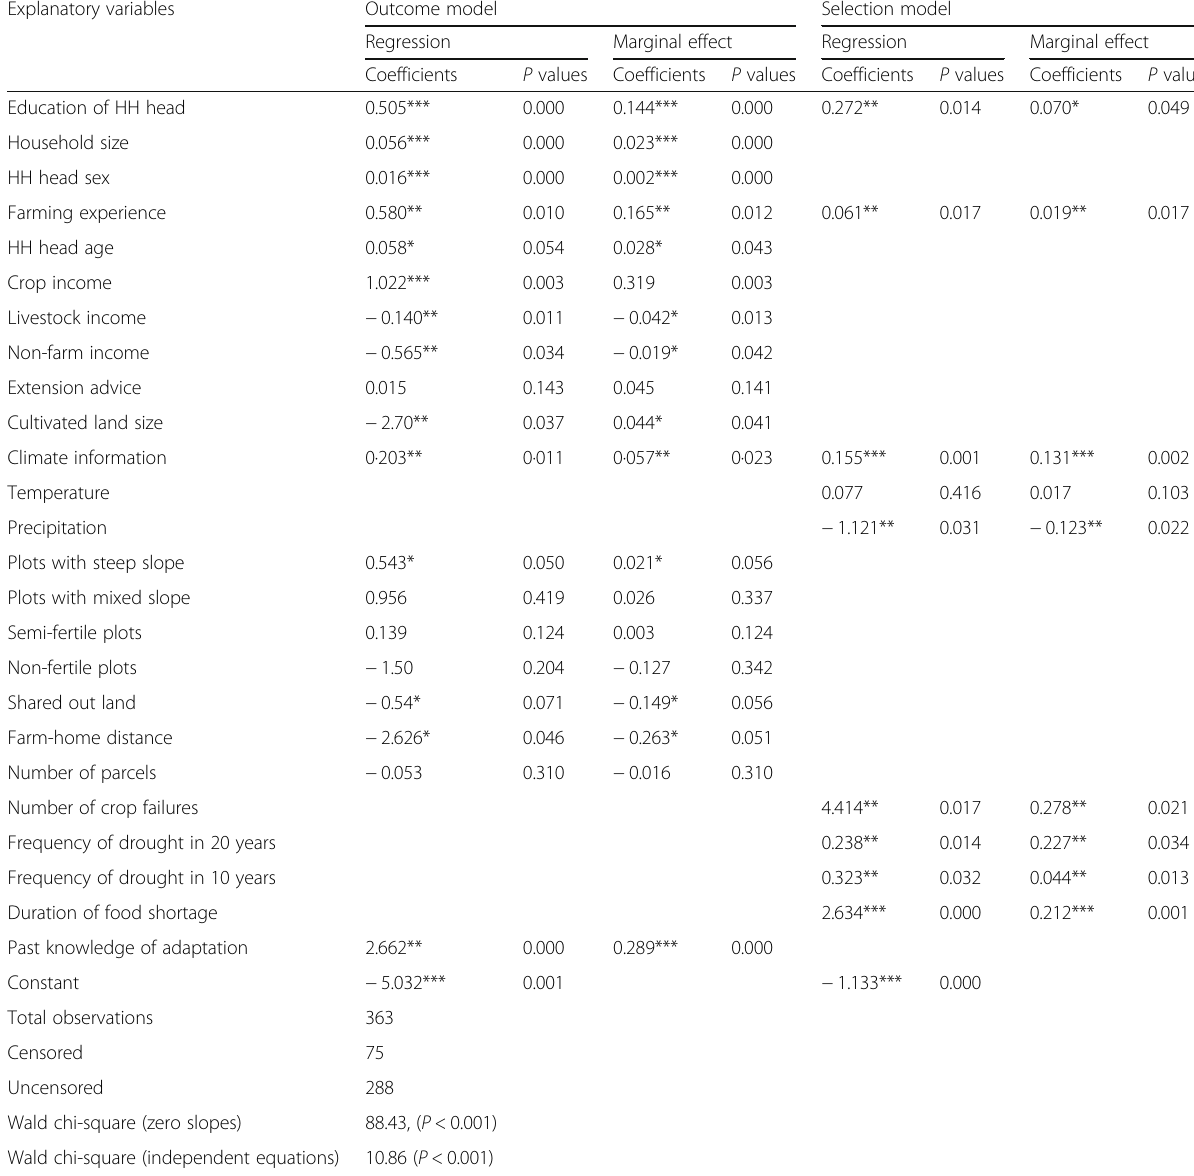
Table 9 Results of the Heckman probit selection model for the dry